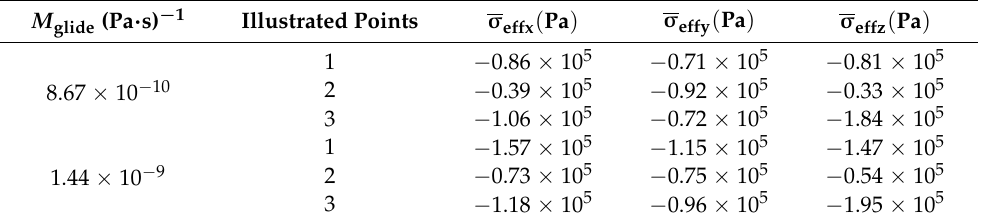
Table 2. The calculated mean effective stresses at the three illustrated points in Figure 9.